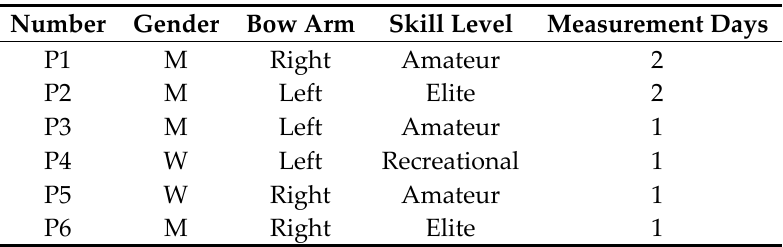
Table 1. Overview about the participants of this